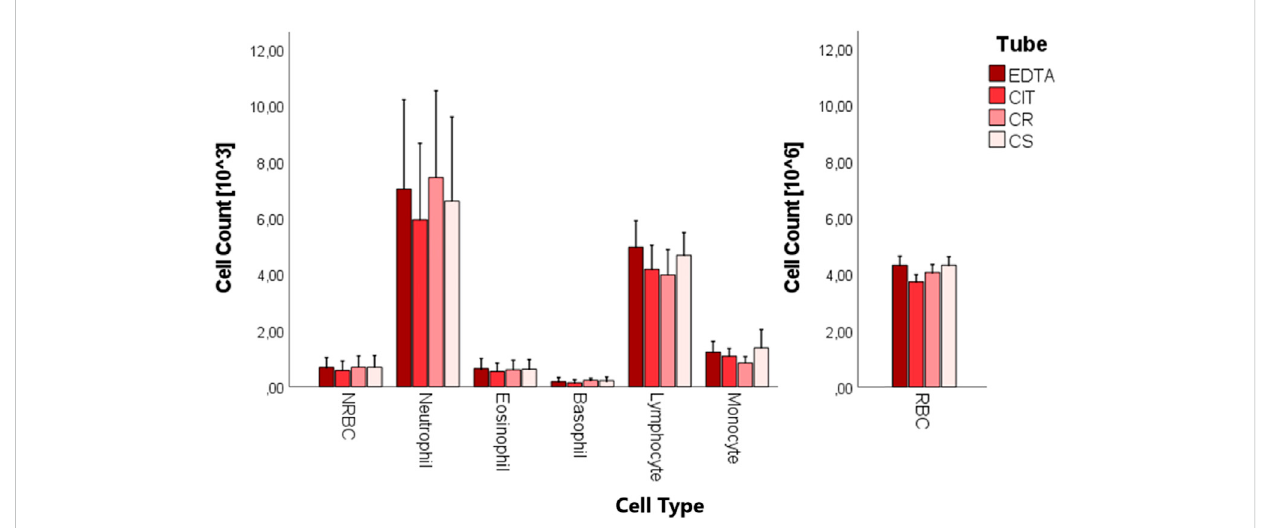
FIGURE 5 Boxplots of cord blood complete blood count analysis in the four tubes (EDTA, CIT, CR, and